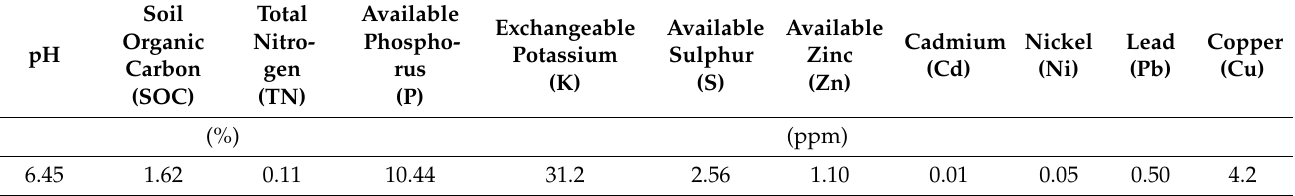
Table 1. Initial soil properties before commencement of the experiment; n =